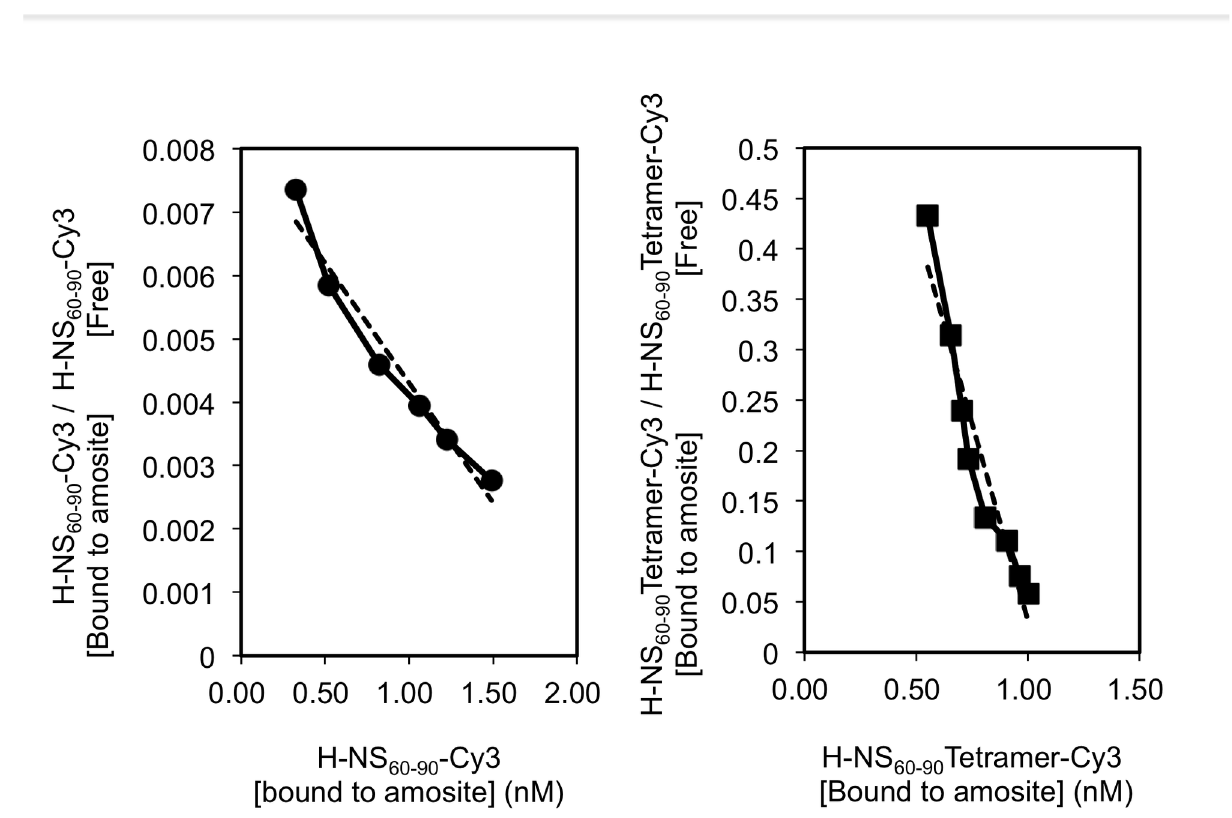
Figure 4. Scatchard analysis of H-NS doi: